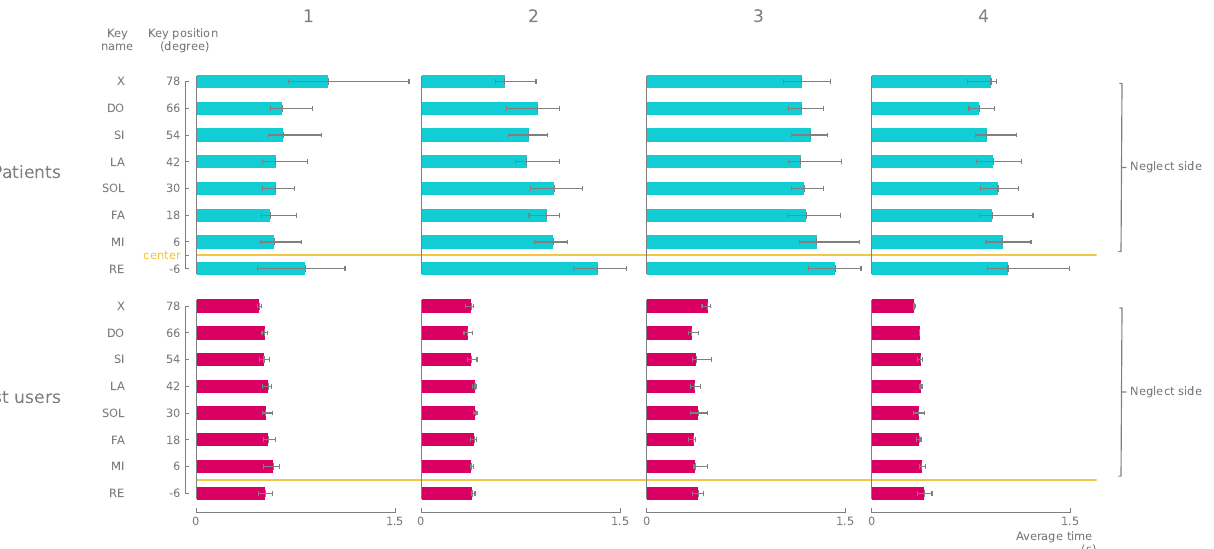
Figure 15. The median of the time it took to hit the required note during the Scales task for patients and test users. Quartiles Q1 and Q3 are indicated by the horizontal lines. Patient 1 required more time to hit the final key at the extreme end of their neglected side, whereas, for all patients, the time to hit the next key reduced gradually as they moved along the scale. The test users indicated a significantly faster response time compared to the clinical